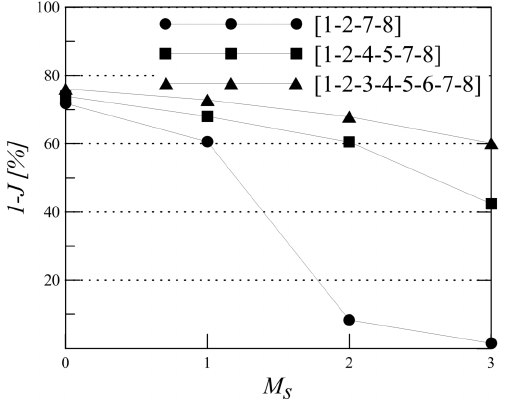
Figure 6. Performance of four-, six- and eight-sensor combinations for increasing sensor malfunctioning M s in the panel represented in Figure 4. P sd = 5% µ and e T = 30